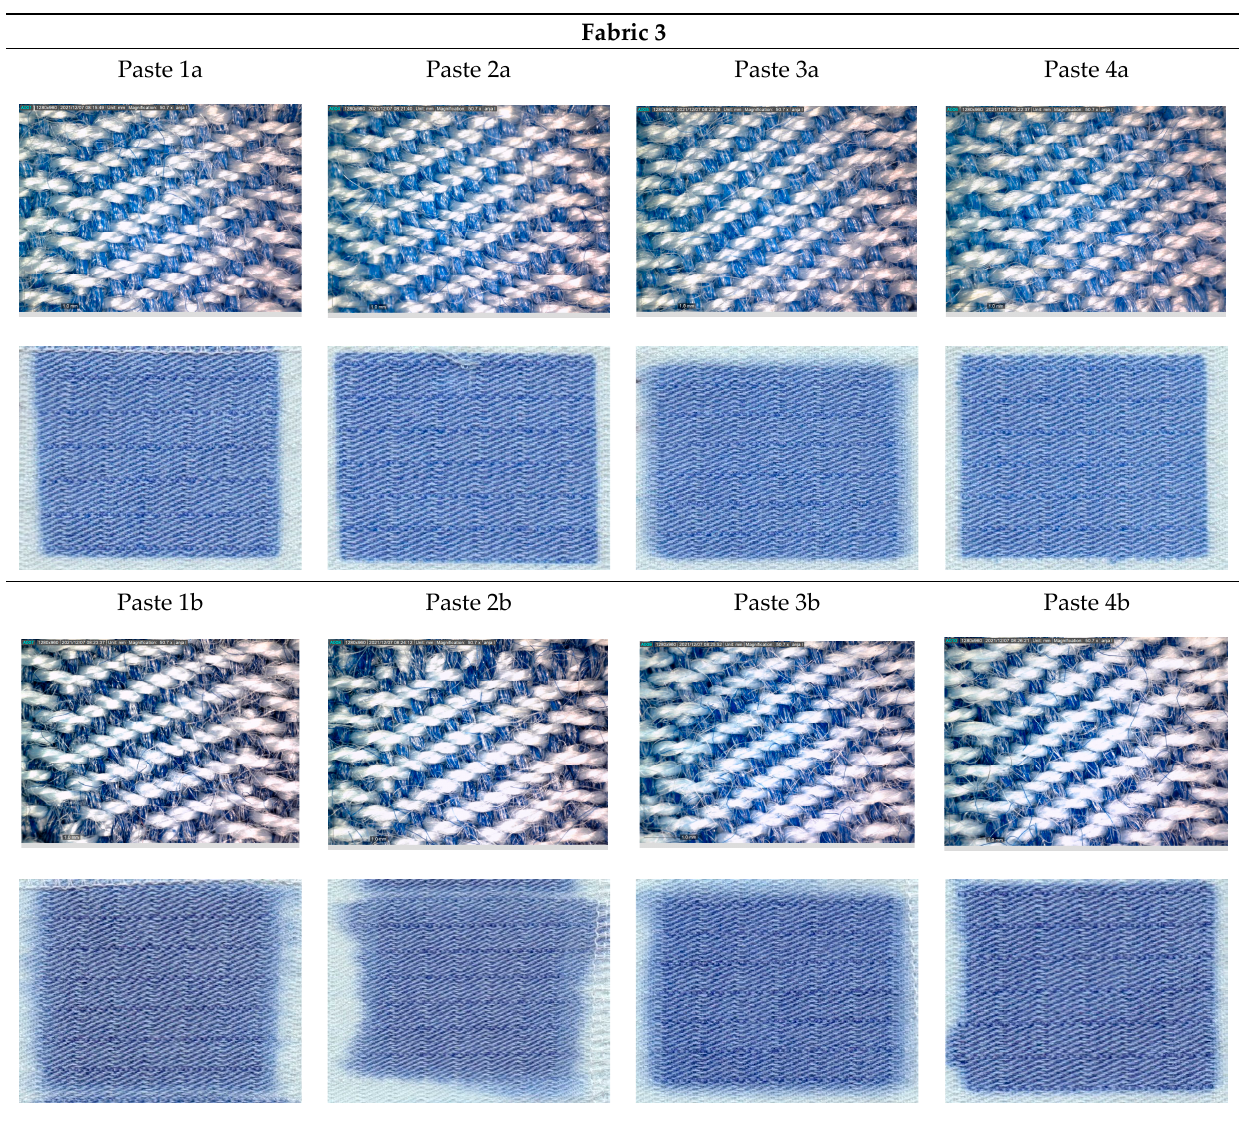
Figure 3. DinoLite microscopic and scanned images of printed Fabric 3.